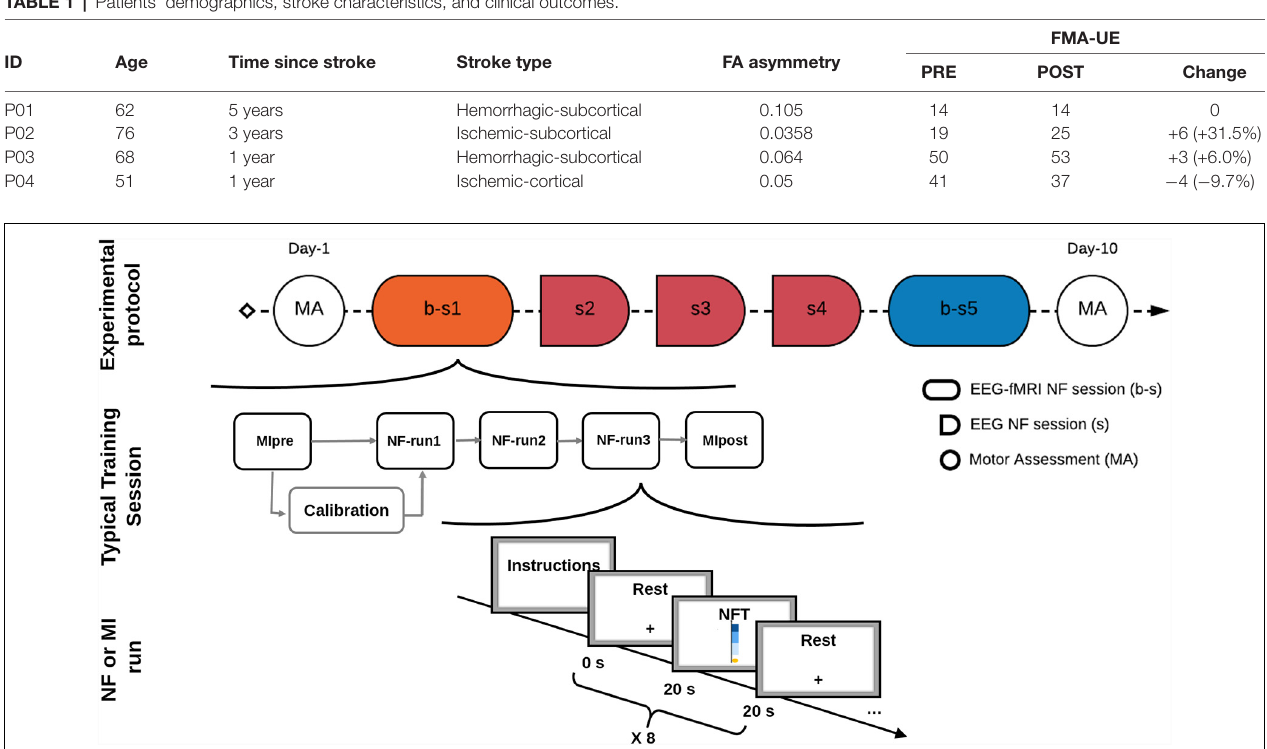
TABLE 1 | Patients’ demographics, stroke characteristics, and clinical outcomes.